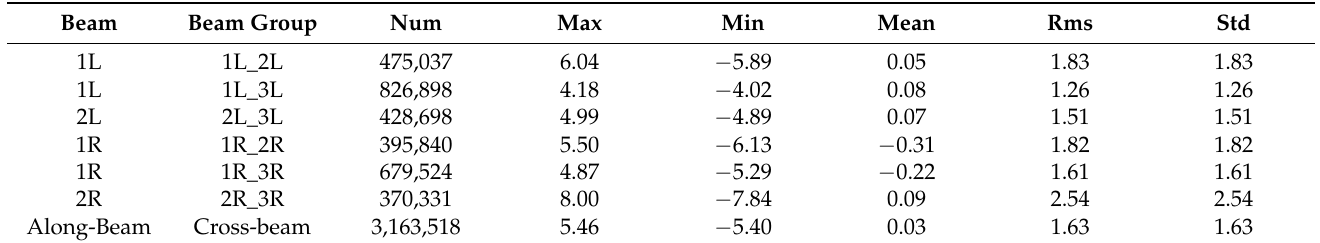
Table 15. Statistics of differences between the joint along-cross DOV and the XGM2019e_2159-DOV model (Unit: arc_sec).